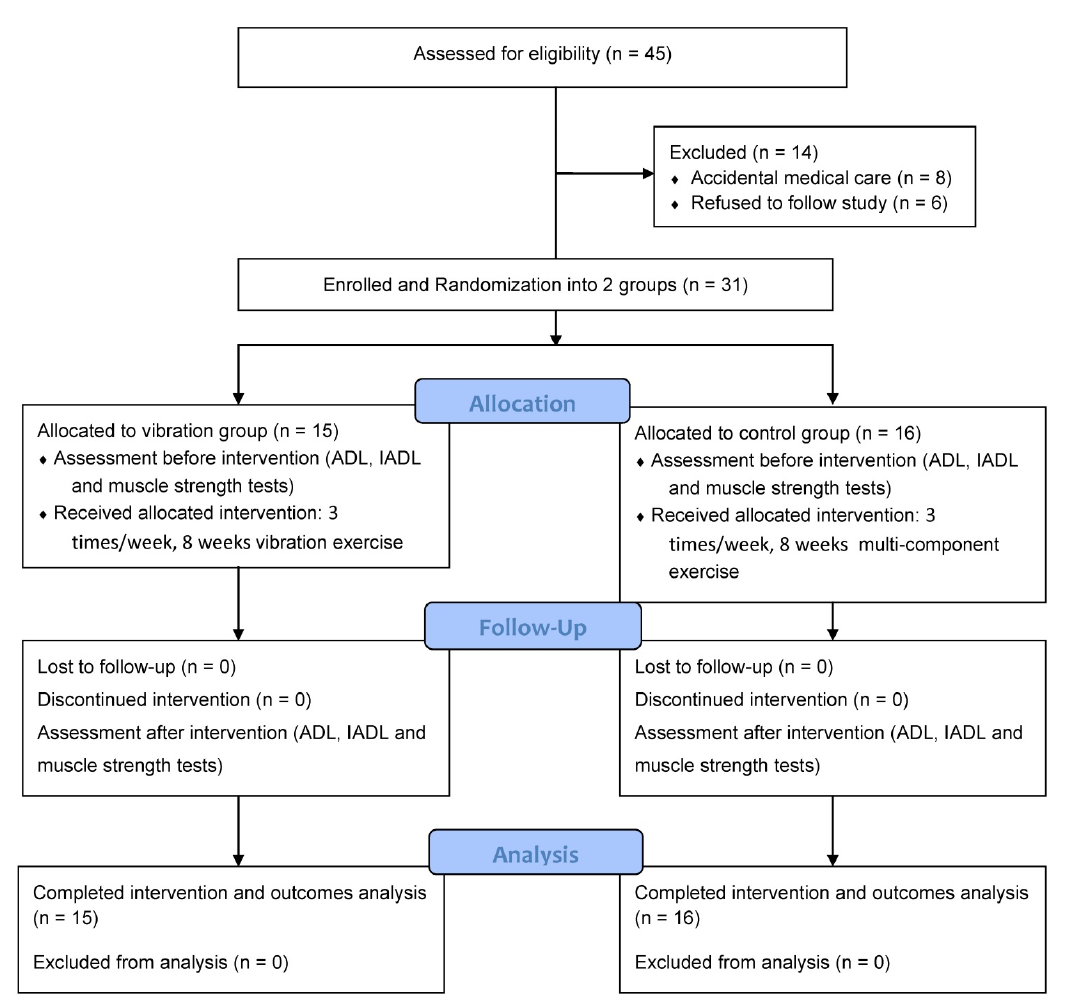
Figure 1. Flow diagram of the randomization procedure and outcome measurements used in the